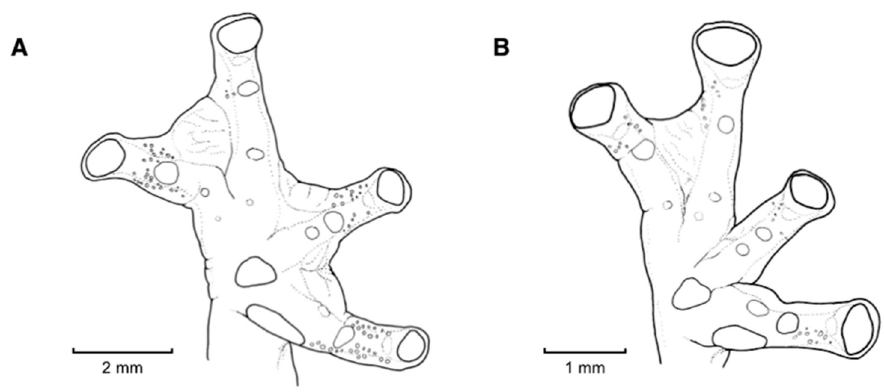
Figure 110. Hyalinobatrachium fleischmanni , variation in hand webbing, ventral view. ( A ) KU 116447. ( B ) QCAZ 22301. Illustrations by Juan M. Guayasamin.